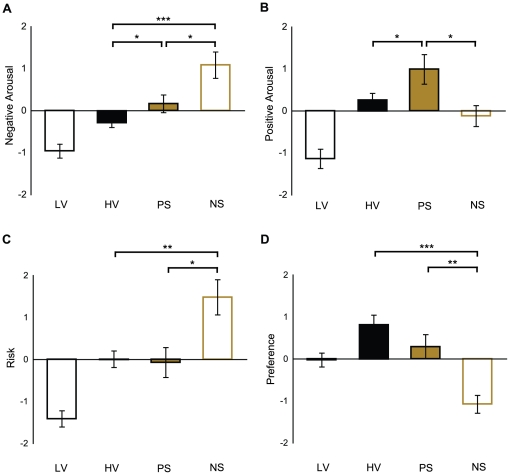
Behavioral data.Low-Variance (LV), High-Variance (HV), Positive-Skew (PS), Negative-Skew (NS) gambles. * p<0.05; ** p<0.01; *** p<0.001 differences between higher variance gambles. Lines represent standard errors of the mean. A. Negative arousal. B. Positive arousal. C. Risk. D. Preference.